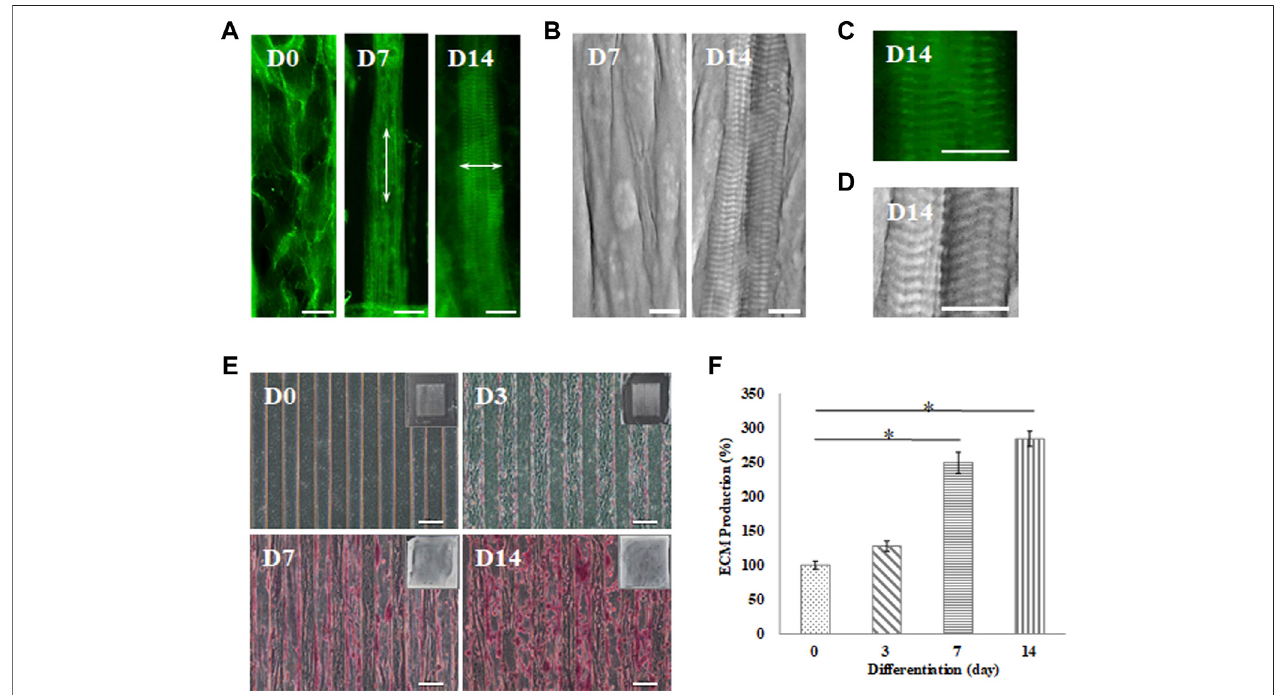
FIGURE 5 | Myotube maturation and ECM secretion demonstrated by the (A) myo fi brils observed under an inverted microscope with F-actin staining and (B) sarcomere examination by SEM on day 7 and 14; the arrow indicates the direction of the actin fi ber. Higher magni fi cation was used to examine the (C) F-actin stain by inverted microscope and (D) sarcomere structures recorded by SEM (scale bar = 30 μ m). (E) Bright fi eld imaging and safranin-O staining were used to examine ECM secretion at day 0, 3, 7 and 14 (scale bar = 100 μ m); (F) The quanti fi cation of the positive safranin-O staining area compared to the total area of the image using ImageJ software. Data are presented as the mean ± SD, n = 3, in three independent experiments, * p <